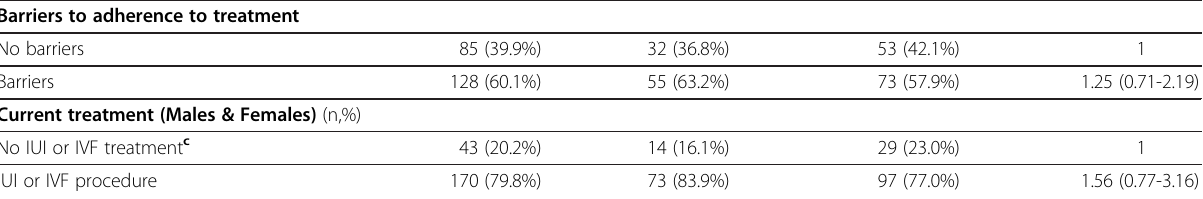
Table 1 Demographic, lifestyle, reproductive and infertility-related characteristics of users and non-users of CAM